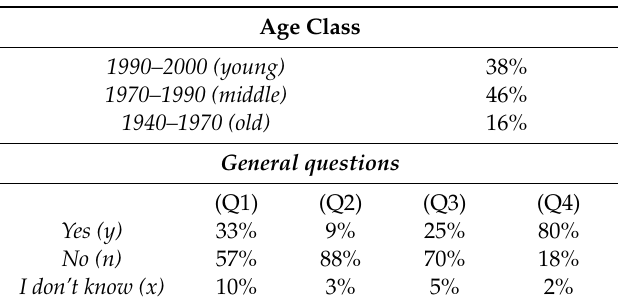
Table 1. User characteristics.